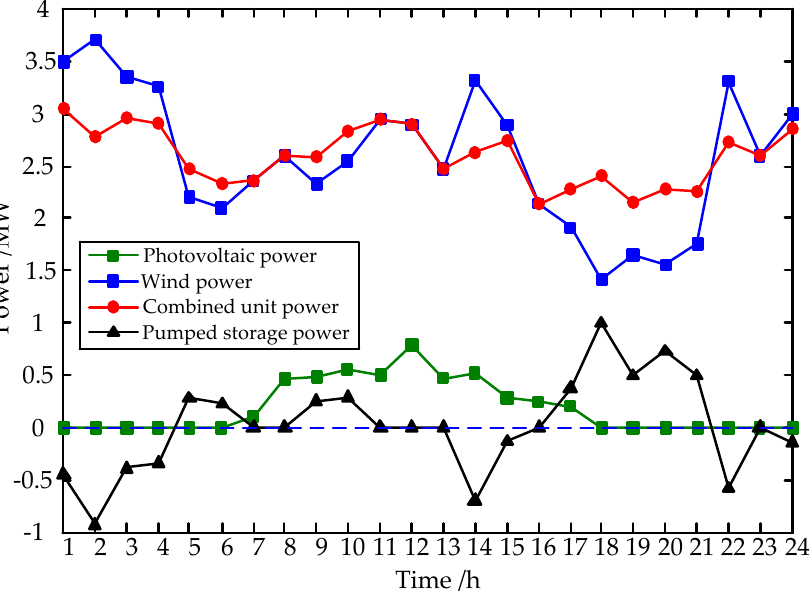
Figure 9. The output curve of each unit after the pumped storage energy flattens on typical day D.